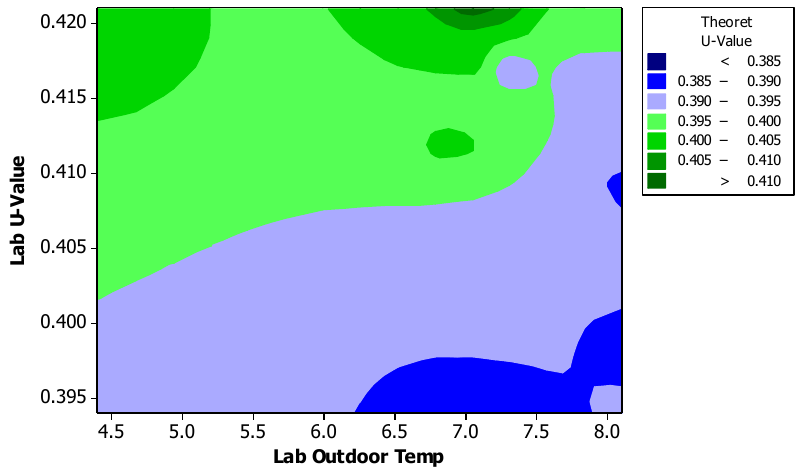
Figure 13. Minitab plots between laboratory measurements and theoretical simulations, demonstrating high and significant R-squared value (80%).